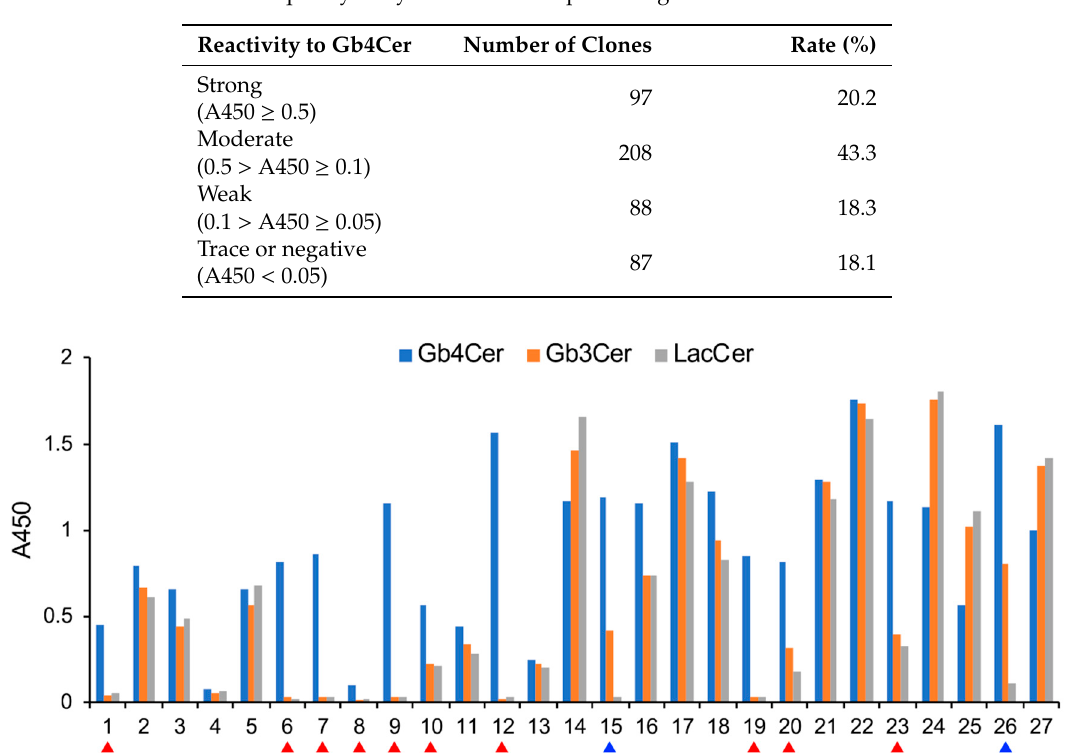
Figure 3. Epitope specificity of antibodies in hybridoma culture supernatants. The reactivity against Gb4Cer, globotriaosylceramide (Gb3Cer), and lactosylceramide (LacCer) of antibodies in hybridoma culture supernatants from 27 clones showing strong reactivity to Gb4Cer in Figure 2 was analyzed by ELISA. These results are summarized in Table 2. Red and blue arrowheads correspond to clones producing anti-Gb4Cer and anti-Gb4Cer/Gb3Cer antibodies, respectively.